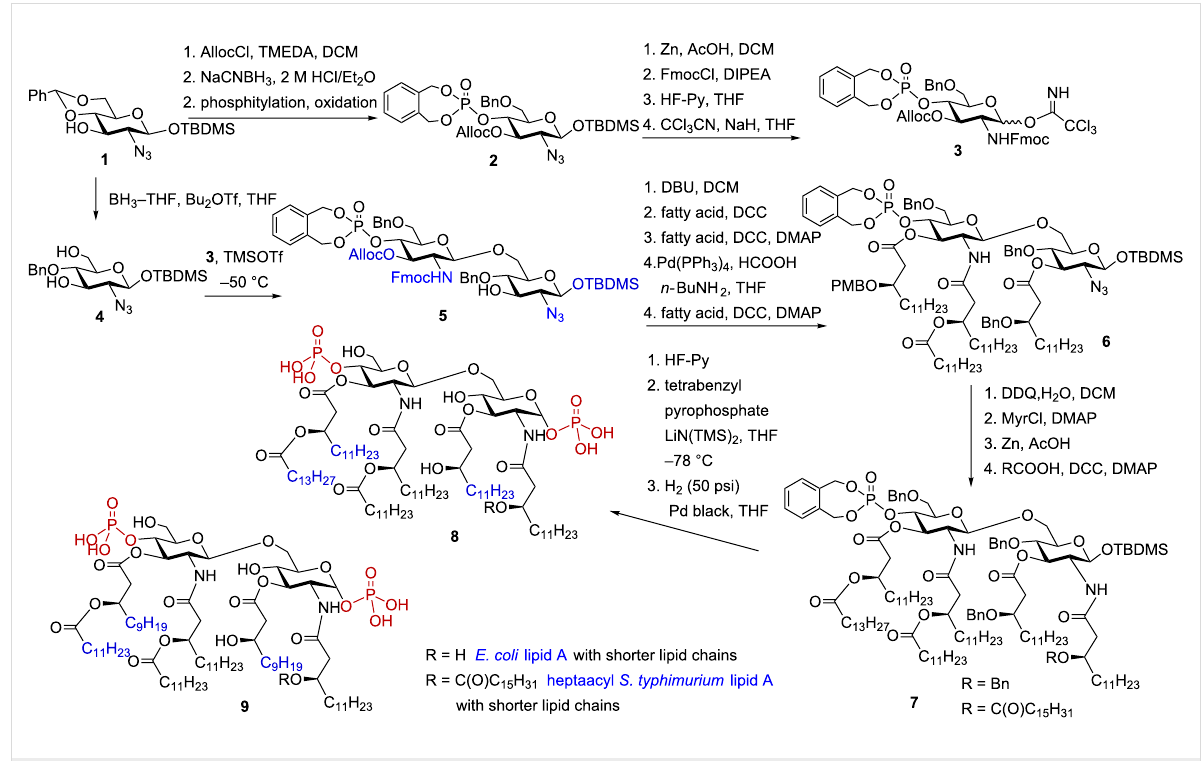
Scheme 1: Synthesis of E. coli and S. typhimurium lipid A and analogues with shorter acyl